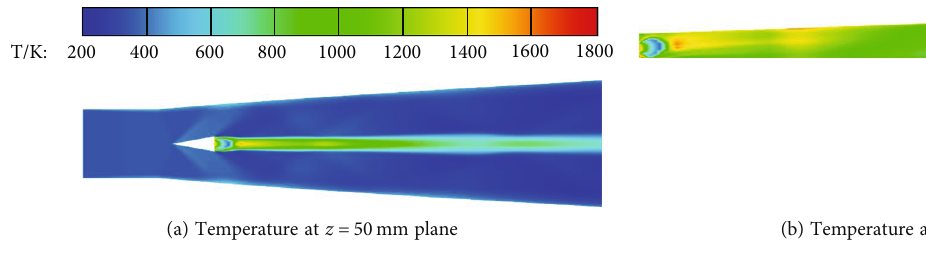
Figure 13: Distribution of